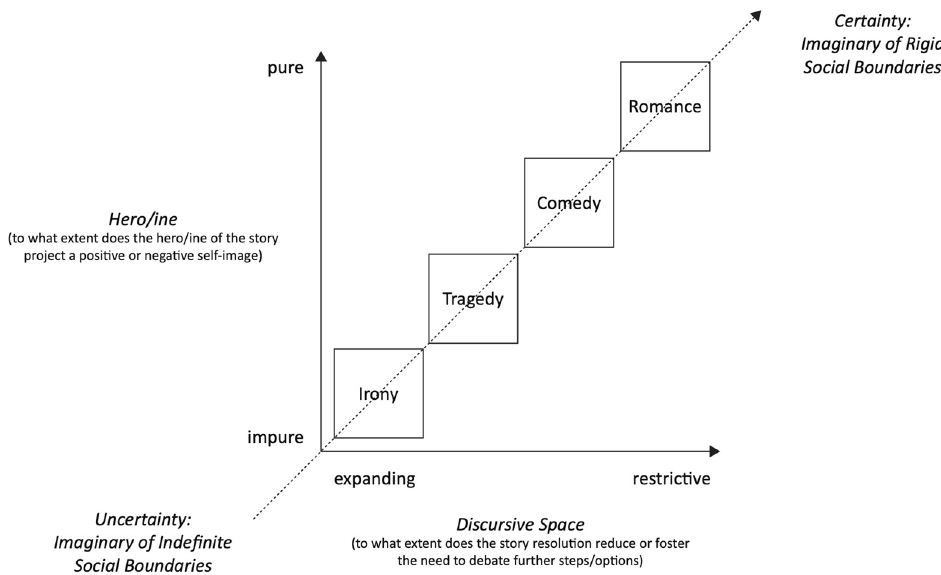
Figure 1. Schematic representation of the link between narrative genre, discursive spaces and social boundaries (Özvatan 2020, p. 289).